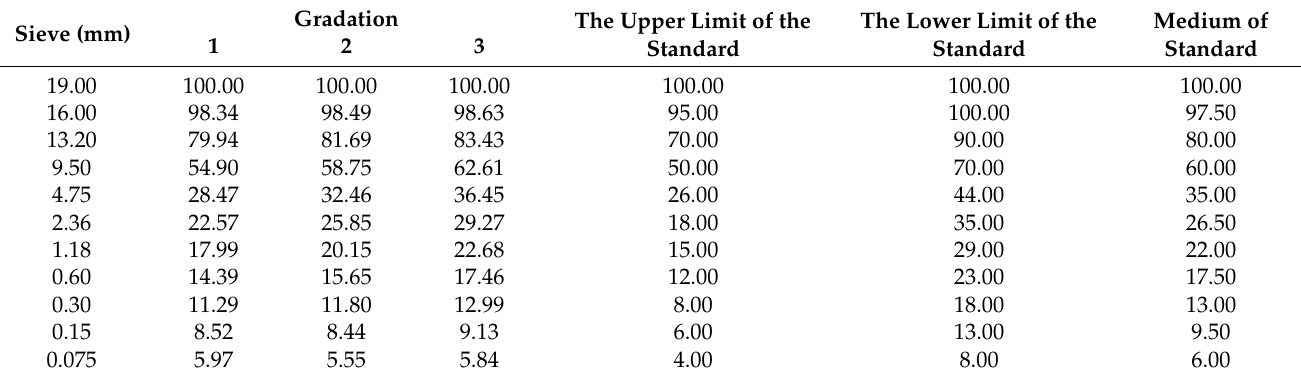
Table 10. Grading range and design grading